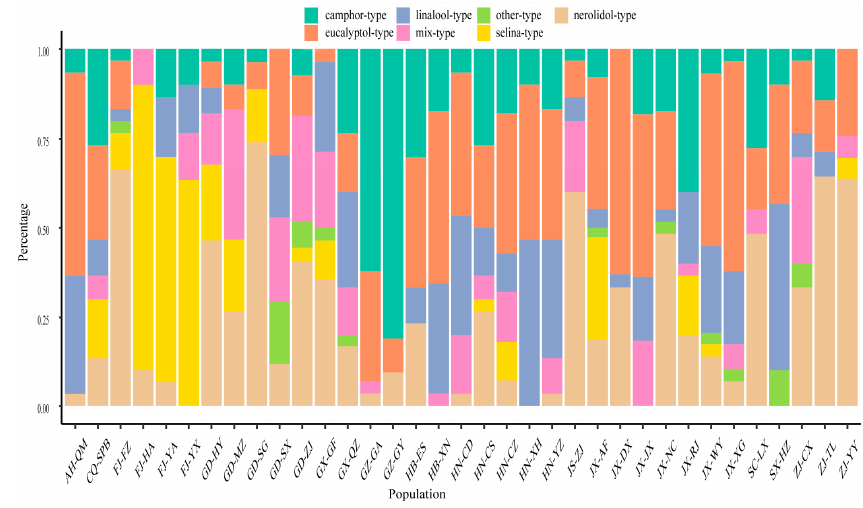
Figure 4. Distribution frequencies of chemotypes in different populations. Pearson’s correlation coefficient analysis of longitude, latitude, and the five major compounds (eucalyptol, linalool, camphor, selina-6-en-4-ol, and trans -nerolidol) corre- lated the variations in essential oil with geographic location (Table 2). A significantly positive correlation was detected between eucalyptol, linalool, and latitude; the higher the latitude, the higher the eucalyptol and linalool contents. Selina-6-en-4-ol was signifi- cantly and positively correlated with longitude and significantly and negatively corre- lated with latitude. trans -Nerolidol was positively correlated with longitude, and cam- phor was negatively correlated with longitude. 2.4. Exceptional Chemotypes Despite the predominance of the eucalyptol, camphor, linalool, nerolidol, and mixed types in camphor trees, 17 individuals were present with high amounts of other com- pounds (Table 3). Six (GX-GF-22, JX-AF-13, JX-XG-21, SX-HZ-22, and SX-HZ-24, SX-HZ-25) of the 17 individual plants exhibited high amounts of methyl isoeugenol (68.29% to 83.60%). Two individual plants (FJ-FZ-30 and GD-ZJ-04) exhibited high amounts of methyl eugenol (87.71% and 84.19%, respectively). Two individuals (JX-NC-23 and JX-WY-20) had high amounts of δ -selinene (74.48% and 60.54%, respec- tively). One individual (GX-QZ-03) had an elevated borneol content (52.22%).